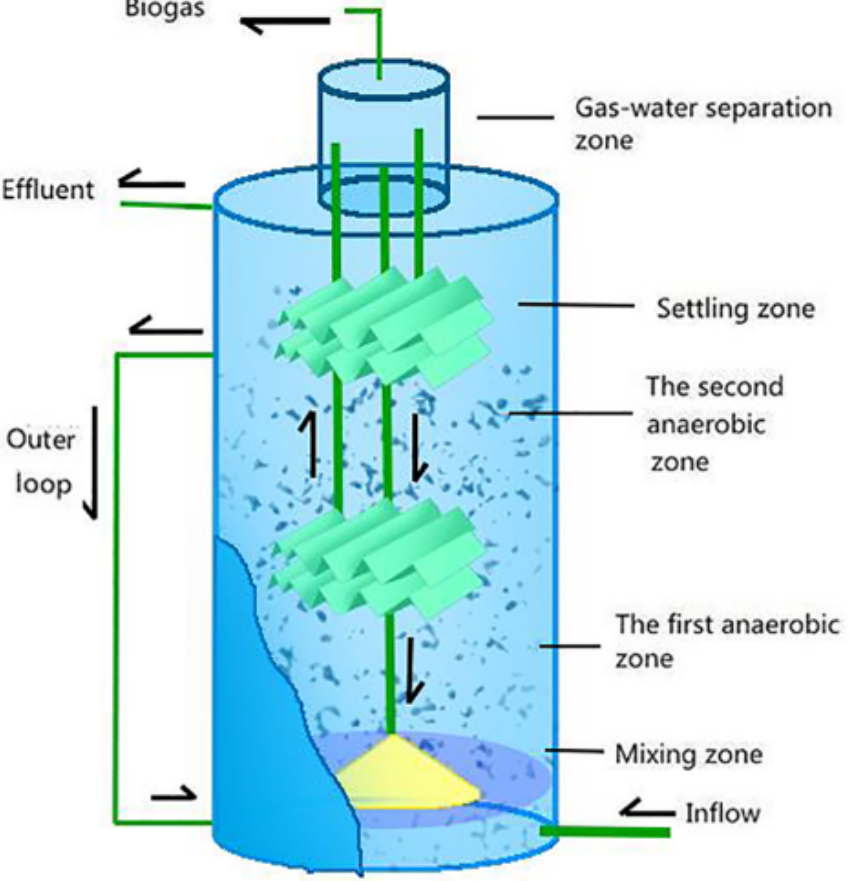
Figure 9. Scheme of an IC reactor [62]. Experiment lasted for two years, and samples of bacterial species were taken at several heights by means of reserved pipes. The high relevance of this solution is revealed by the results, which showed a total COD removal efficiency between 80% and 84%. In Table 2, a comparison of the proposed innovative plants is made basing on the technology, the analyzed waste, the operating conditions and the scaling of the system. Proper references are